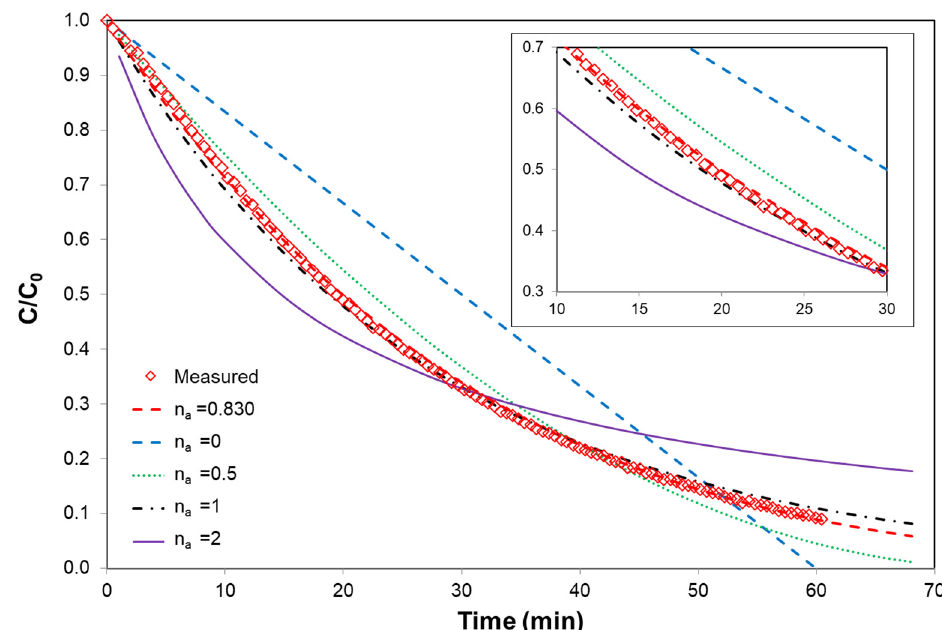
Figure 4. Photocatalytic degradation of 20 µ M ofloxacin in the presence of 2 mg L − 1 TiO 2 . Red squares represent measured values, whereas lines represent different calculated amounts using Equations (2) and (3) and optimized kinetic coefficient parameters (see Table 1). Inset emphasizes fits and differences close to t 1/2 = 19.8 min.